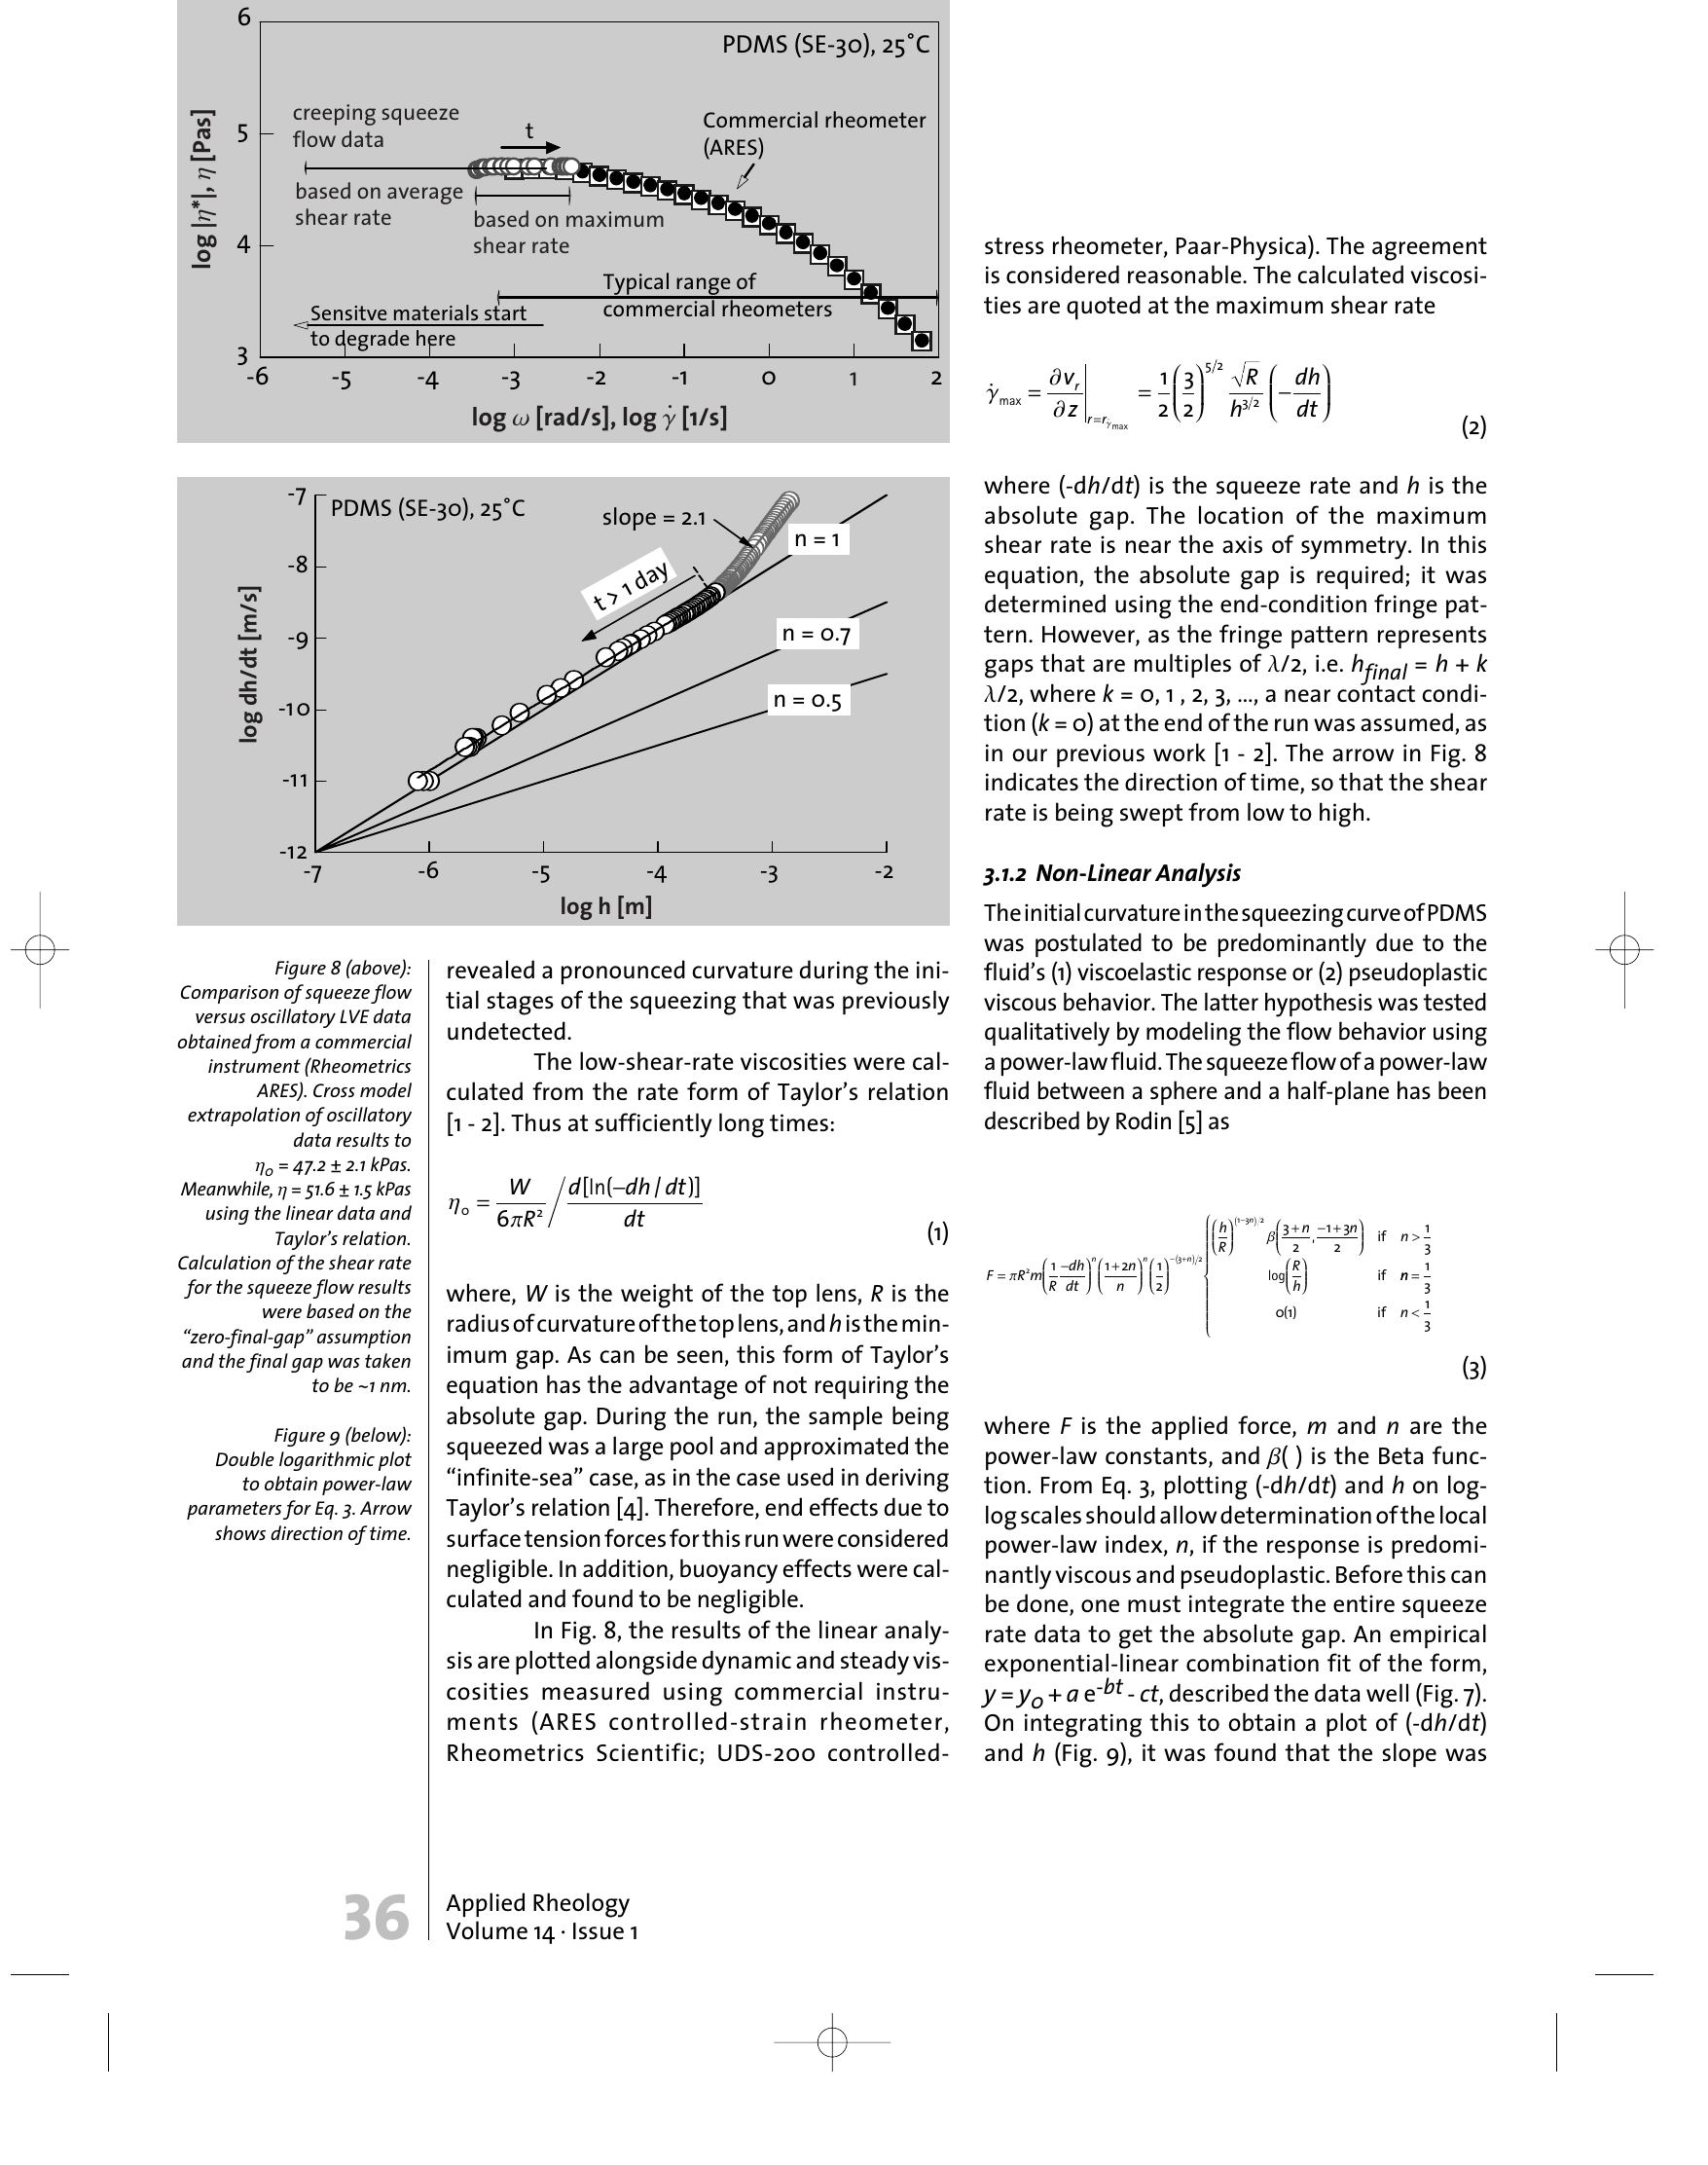
Comparison of squeeze flow versus oscillatory LVE data